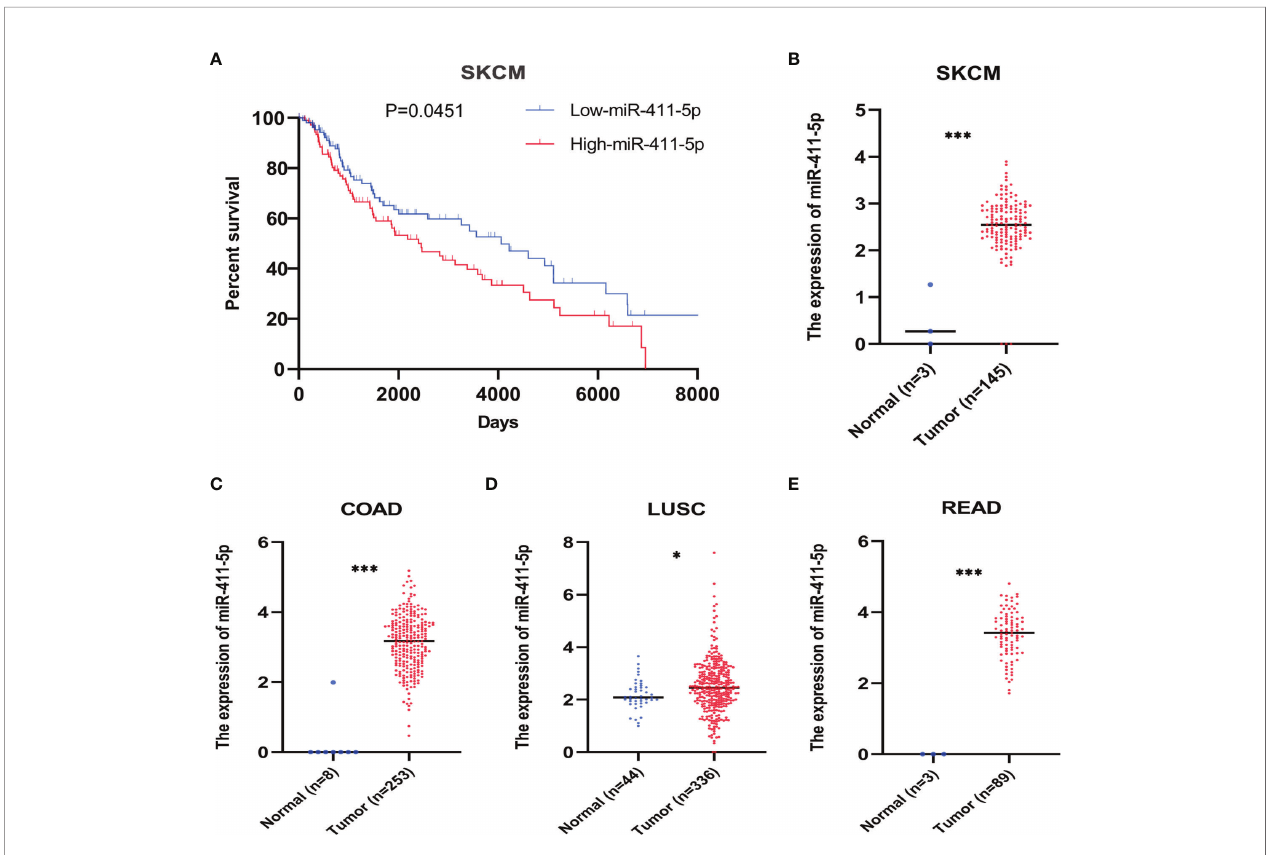
FIGURE 6 | Bioinformatic analysis of miR-411-5p expression in human cancers. (A) The overall survival curves of melanoma patients with low expression of miR-411-5p and melanoma patients with high expression of miR-411-5p. The expression of miR-411-5p between normal tissue and tumor in SKCM (Skin Cutaneous Melanoma) (B) , ***p < 0.001), COAD (Colon adenocarcinoma) (C) , ***p < 0.001), LUSC (Lung squamous cell carcinoma) (D) , *p < 0.05) and READ (Rectum adenocarcinoma) (E) , ***p <